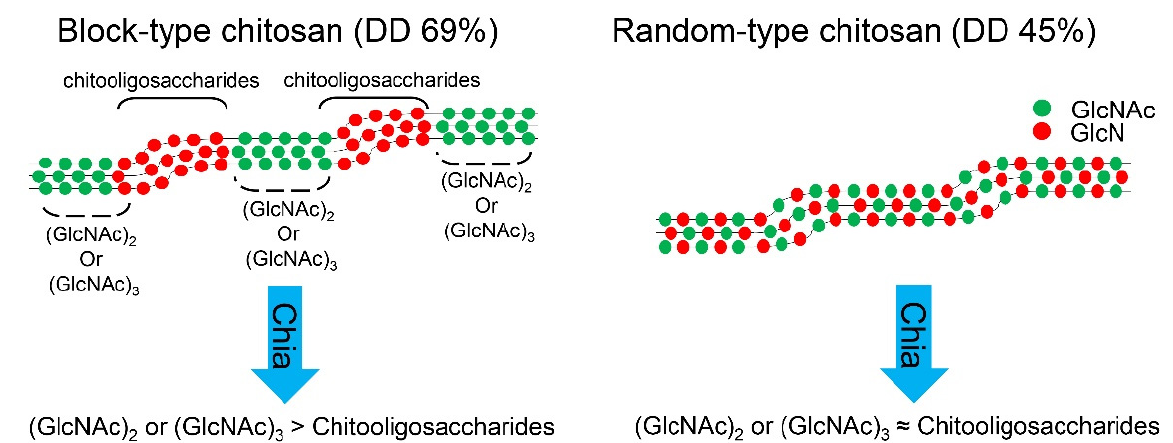
Figure 6. Chitosan structure and mode of degradation by Chia. The chitosan structure and mode of degradation by Chia are illustrated.